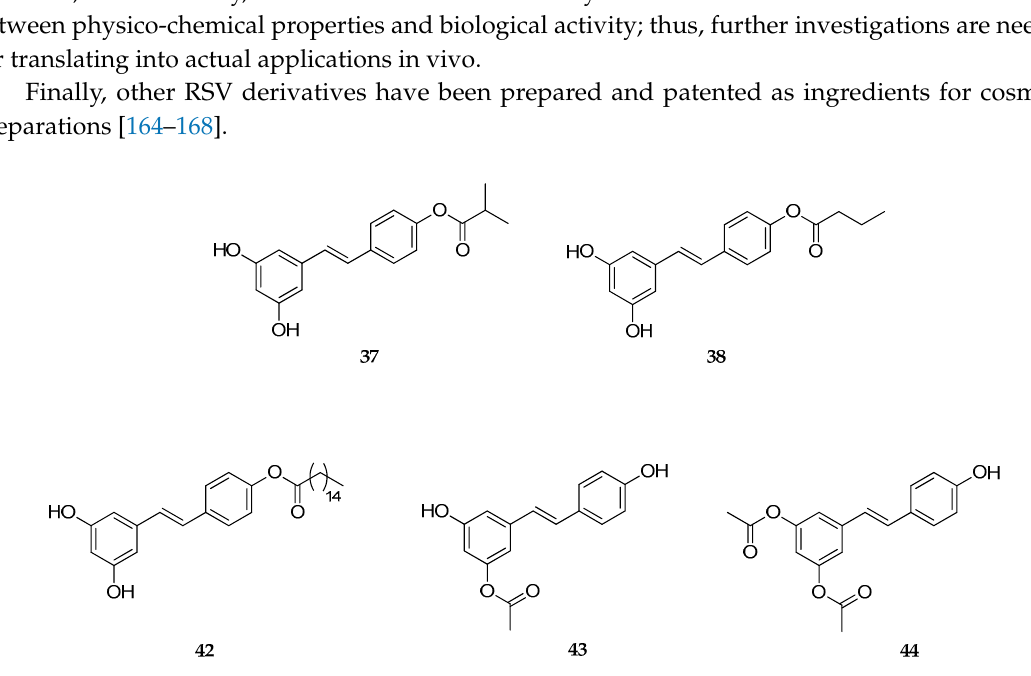
Figure 16. Chemical structures of RSV 4’-isobutyrate ( 37 ), RSV 4’-butyrate ( 38 ), RSV 4’-palmitoate ( 42 ), RSV 3-acetate ( 43 ), and RSV 3,5-diacetate ( 44 ).